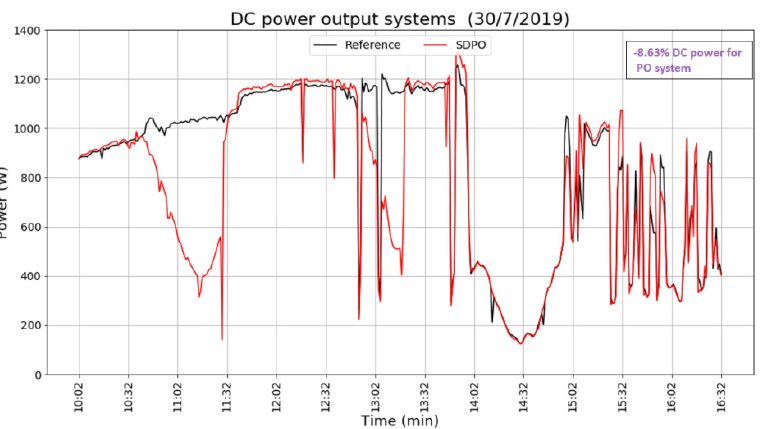
Figure 8. Power comparison of SDPO and reference system when the SDPO system is partially shaded on the un-optimized panels.